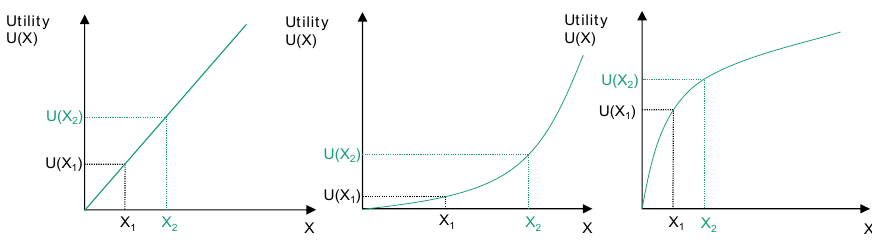
Figure 3. Utility functions (linear, convex, concave).